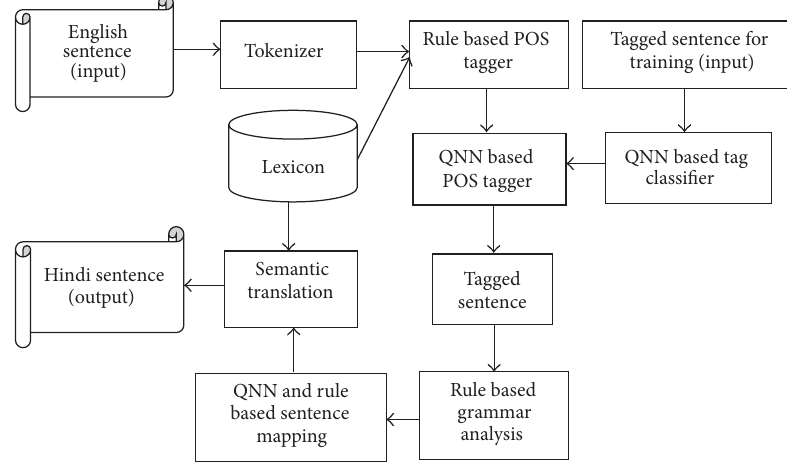
Figure 1: Architecture of MT system model.